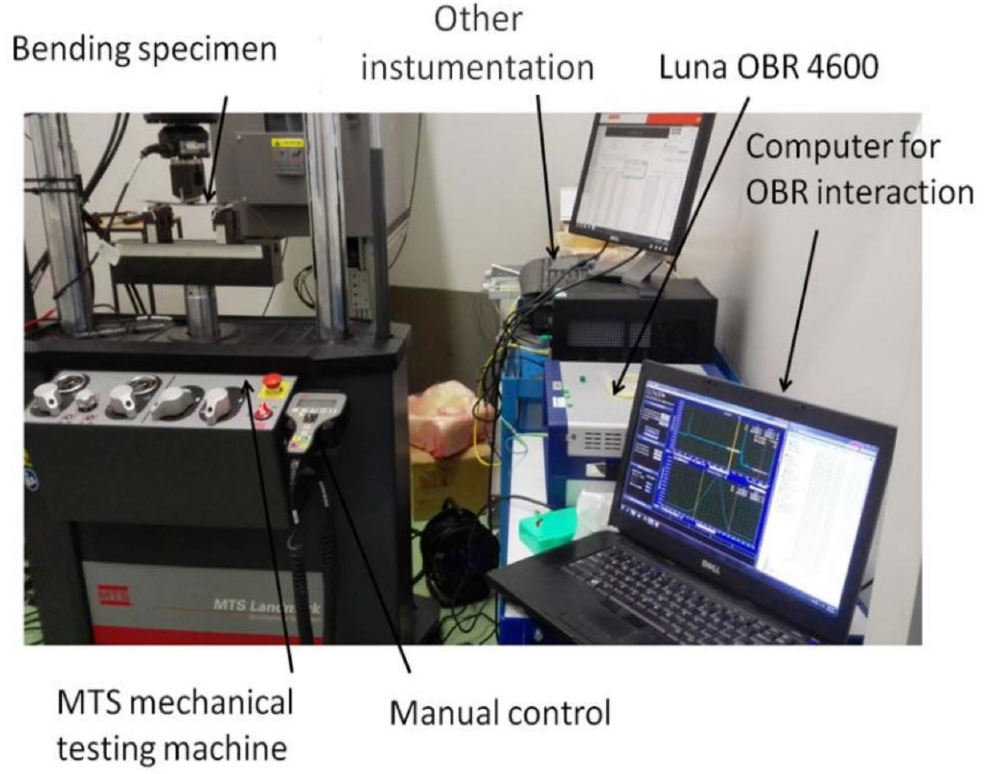
Figure 8. Bending experiment final